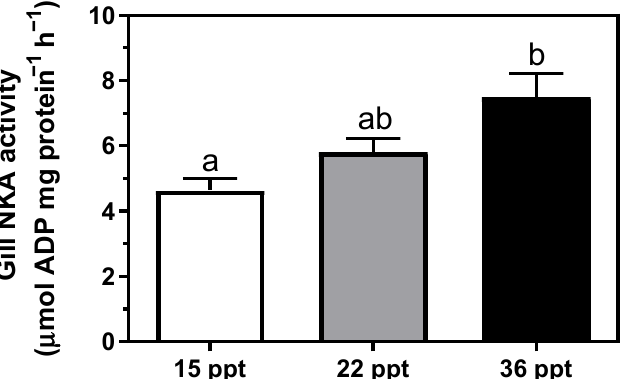
Figure 2. Gill NKA activity in S. dumerili individuals acclimated to different environmental salinities (15, 22, and 36 psu). Data are presented as mean ± SEM (n= 11–12). Different superscript letters indicate significant differences among salinities ( p < 0.05, one-way ANOVA followed by Tukey´s post hoc test).